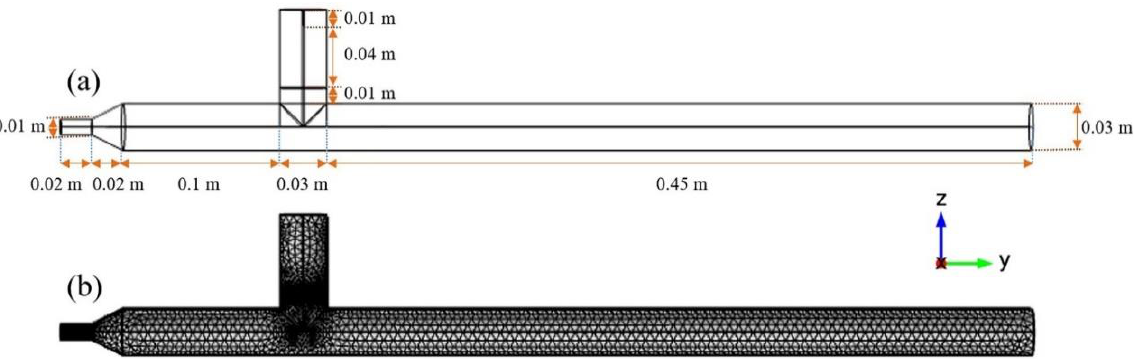
Figure 2. Computational domain of the electrospray pyrolysis reactor: ( a ) physical dimensions; ( b ) mesh.